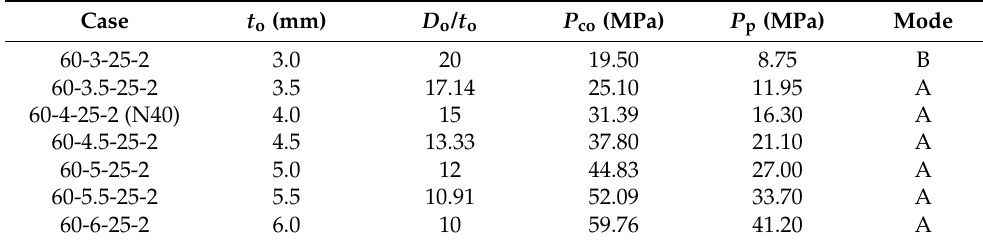
Table 8. Effect of thickness of the outer pipe.